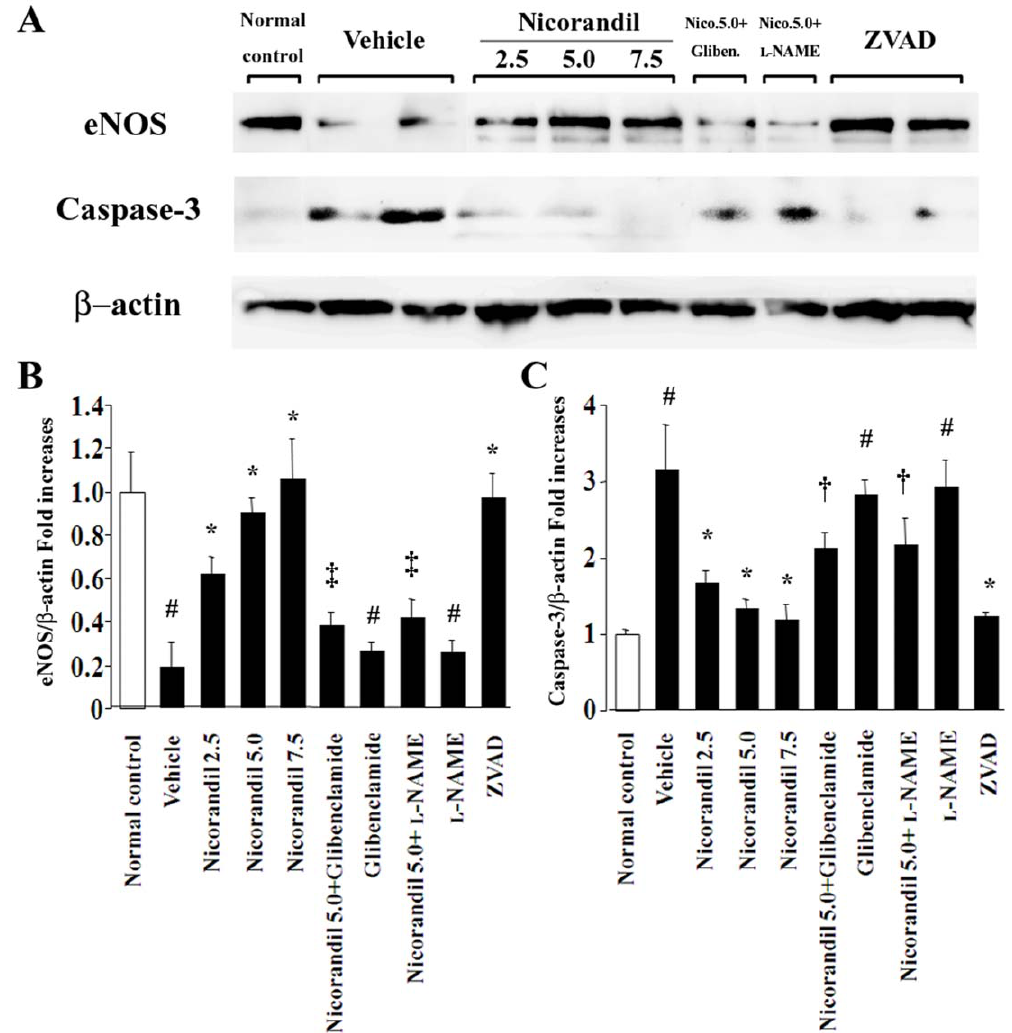
Figure 4. Nicorandil restores the downregulated eNOS expression and attenuates the upregulated caspase-3 expression in MCT- injured lungs. ( A ) The expressions of eNOS and cleaved caspase-3 in lungs were determined by western blotting. MCT significantly downregulated the expression of eNOS and inversely upregulated the expression of cleaved caspase-3 ( see vehicle). Nicorandil and ZVAD-fmk restored eNOS expression and attenuated caspase-3 expression in MCT-injured lungs, which were blocked by glibenclamide and L -NAME. Bands were quantified using a lumino-analyzer, and the data of eNOS ( B ) and caspase-3 ( C ) expressions were expressed as fold increases normalized to b -actin expression. # P , 0.01 vs. normal control; * P , 0.05 vs. vehicle; { P , 0.05 and { P , 0.01 vs. nicorandil (5.0 mg ? kg 2 1 ? day 2 1